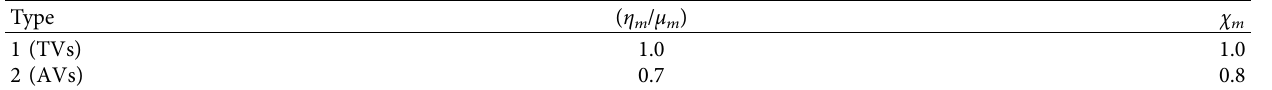
Table 6: Parameters of vehicle